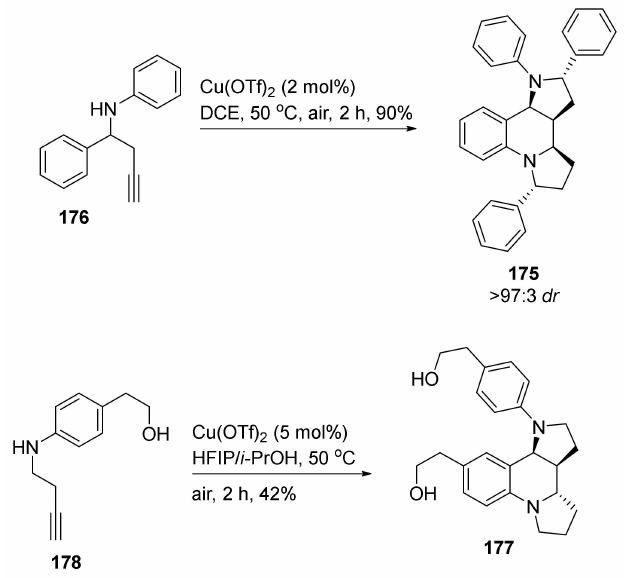
Scheme 29. Dipyrroloquinoline scaffold synthesis by Li and